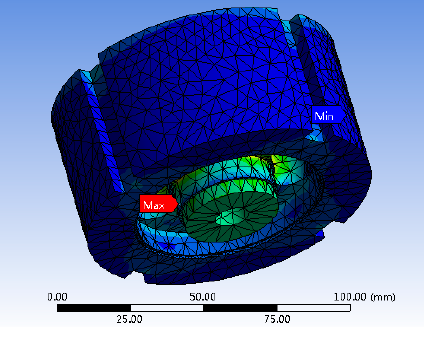
Figure 10. Stress cloud image.